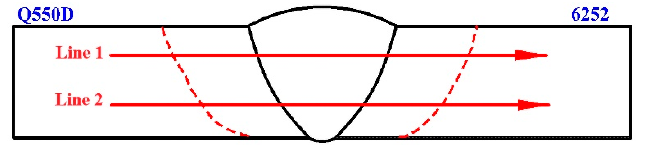
Figure 7. The measured hardness location.